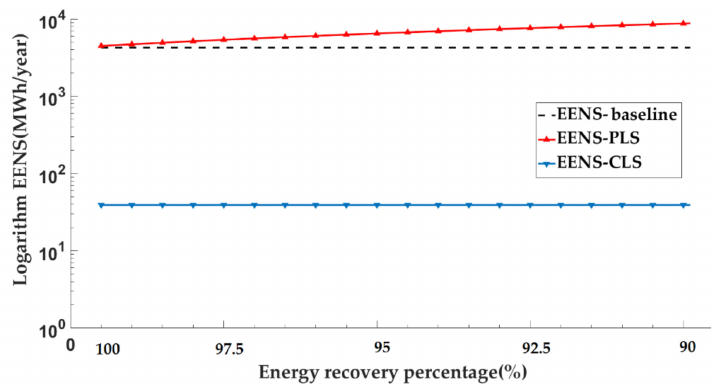
Figure 13. EENS of PLS and CLS for Model 4.